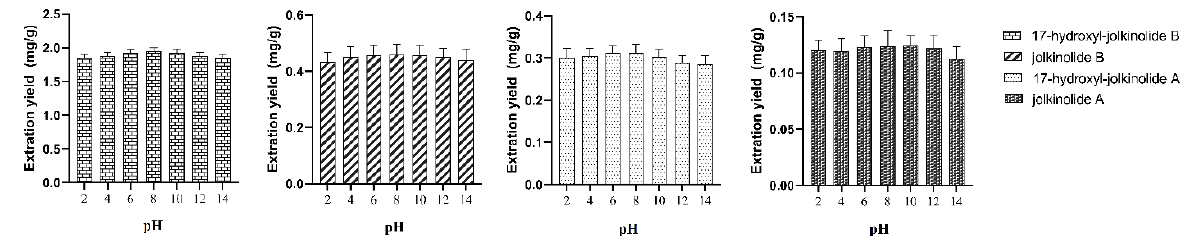
Figure 9. The effect of pH.